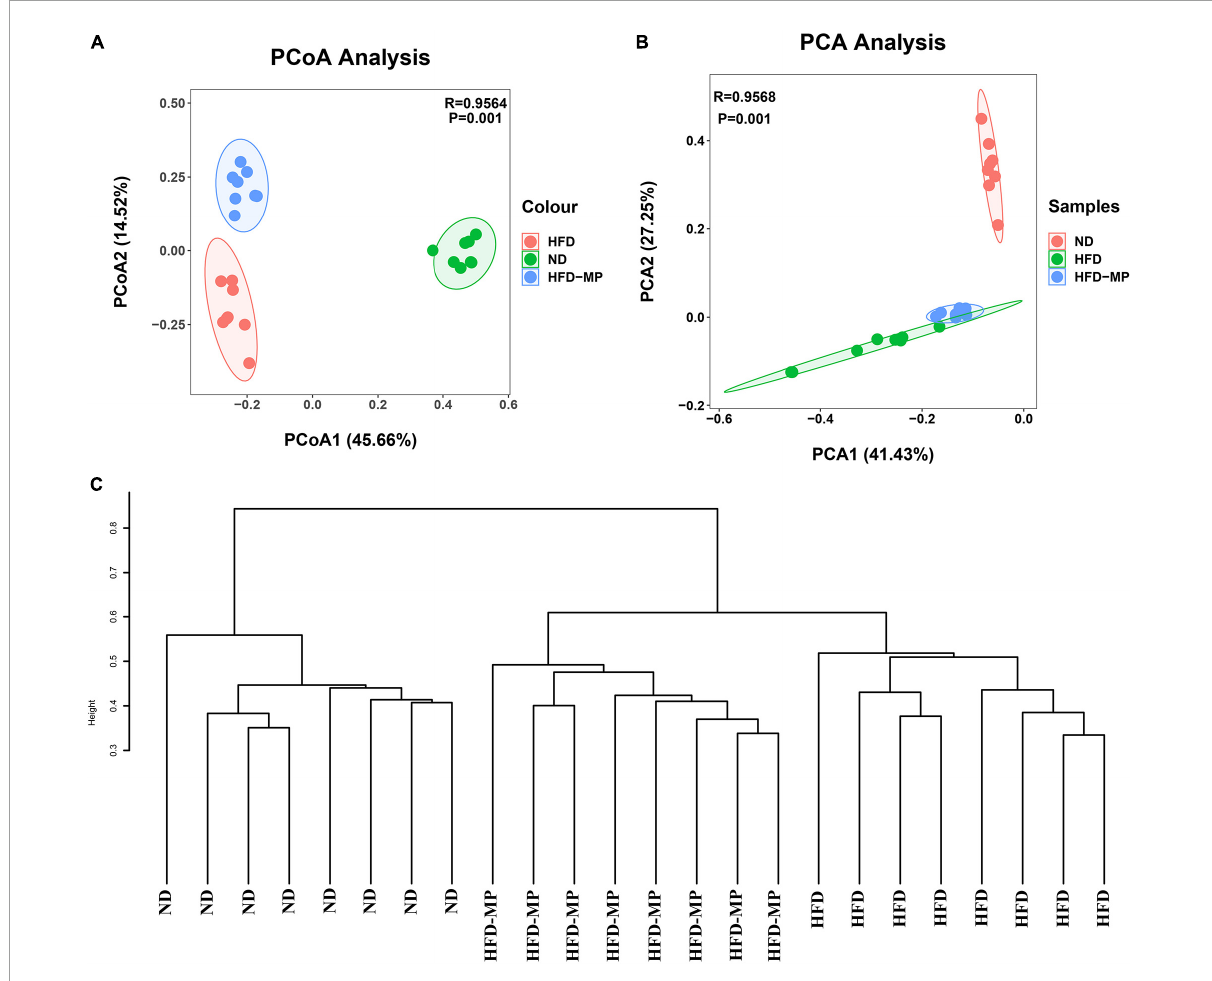
FIGURE4 MPs attenuated HFD-induced dysbiosis of gut microbiota evaluated by beta-diversity analyses, including (A) PCoA, (B) PCA, and (C) hierarchical cluster analysis.